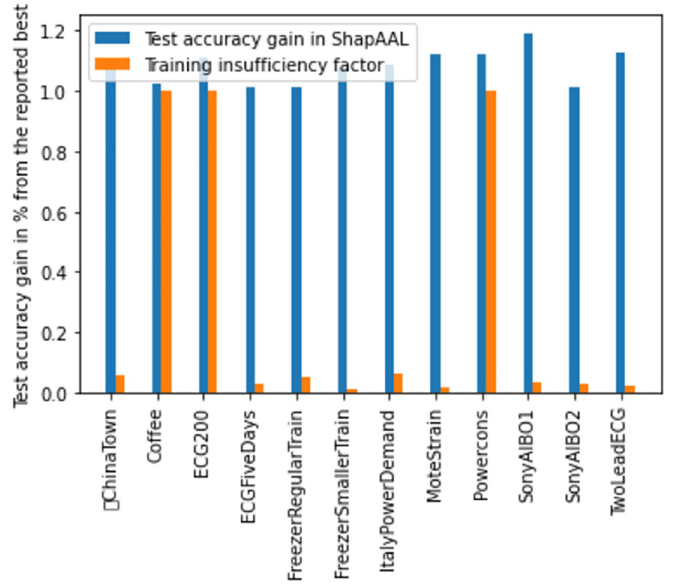
Fig 16. Empirical support of consistency in learning gain over test data of ShapAAL ( M Shapley ) over base model ( M ) under typical practical constraint of training insufficiency factor � 1.